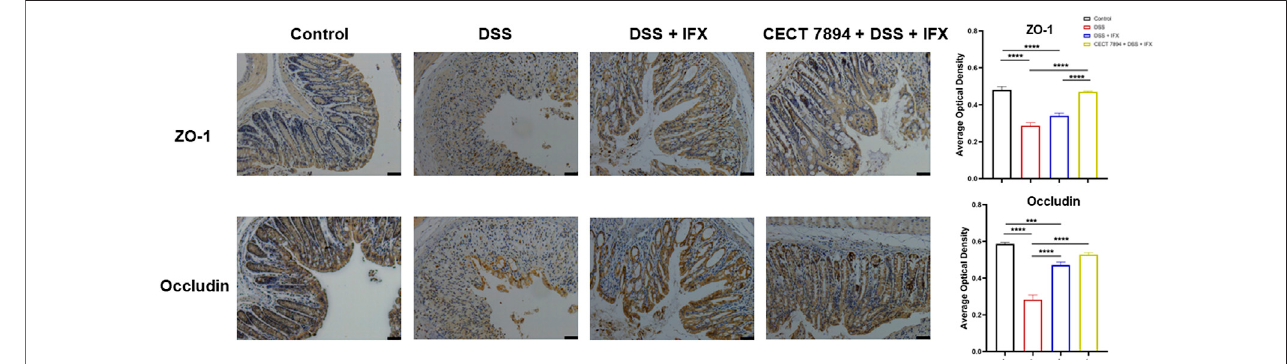
FIGURE2| B.longum CECT7894increasestightjunctionproteins expression. RepresentativeabundancesofZO-1and Occludinweretested inthecolontissues by immunohistochemical staining ( n = 6 per group). The scale bar represents 25 µm in each image. Statistical signi fi cance was assessed by using one-way ANOVA